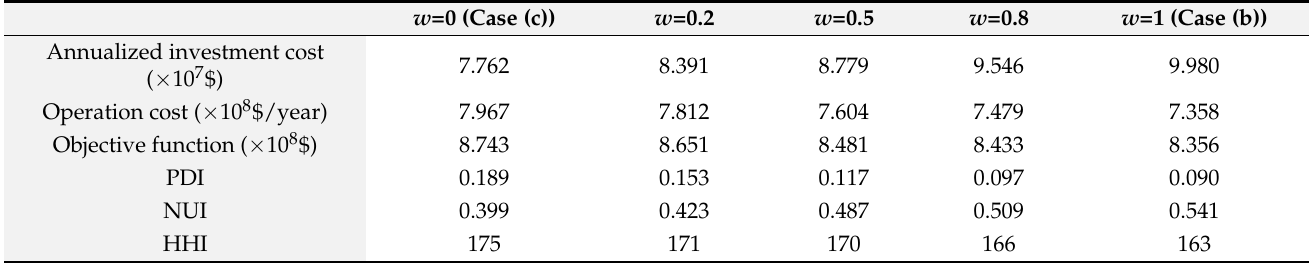
Table 2. Optimal solutions for four different cases considering different weighting factors.